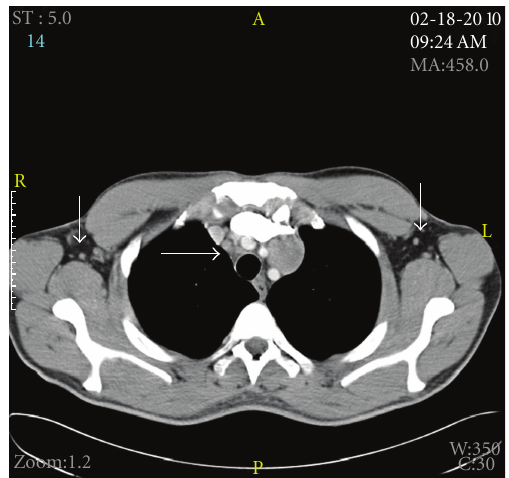
Figure 1: CT chest showing mediastinal lymphadenopathy and bilateral axillary enlarge lymph nodes.